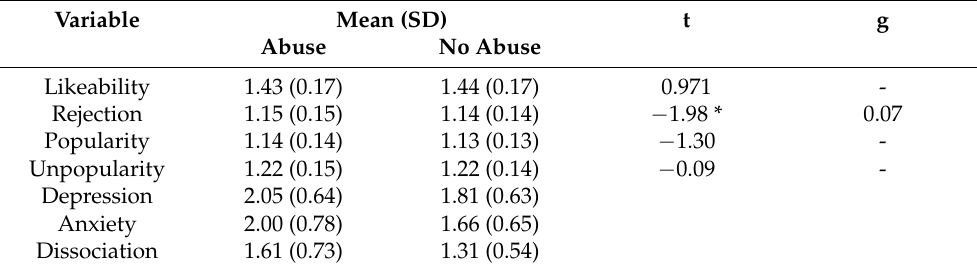
Table 1. Descriptive statistics, sample mean levels (and standard deviations) of all observed variables (abuse n = 394, no abuse n = 1565) and effect sizes (Hedges’ g).